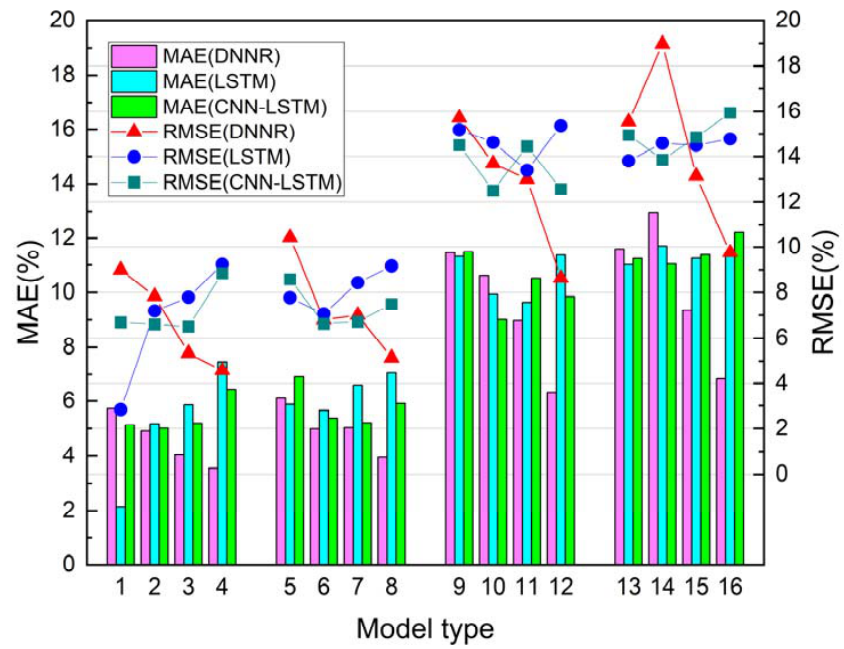
Figure 10. The RMSE and MAE of the best experimental model for Greenhouse A temperature un ‐ der 16 datasets.